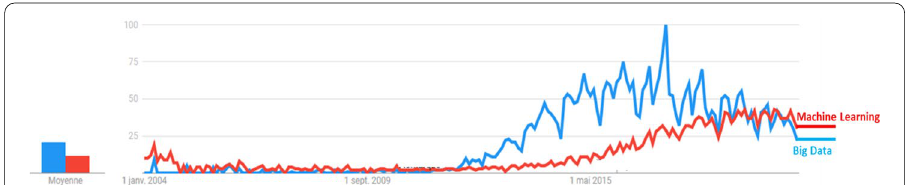
Fig. 1 “Big Data” and “Machine Learning” search trends, 2004–2020. Data source: Google Trends (https ://www. googl e.com/trend s)